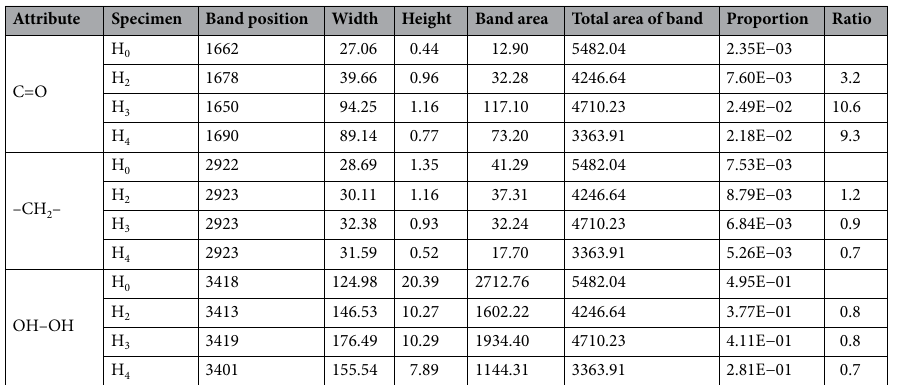
Table 4. Active functional group content in